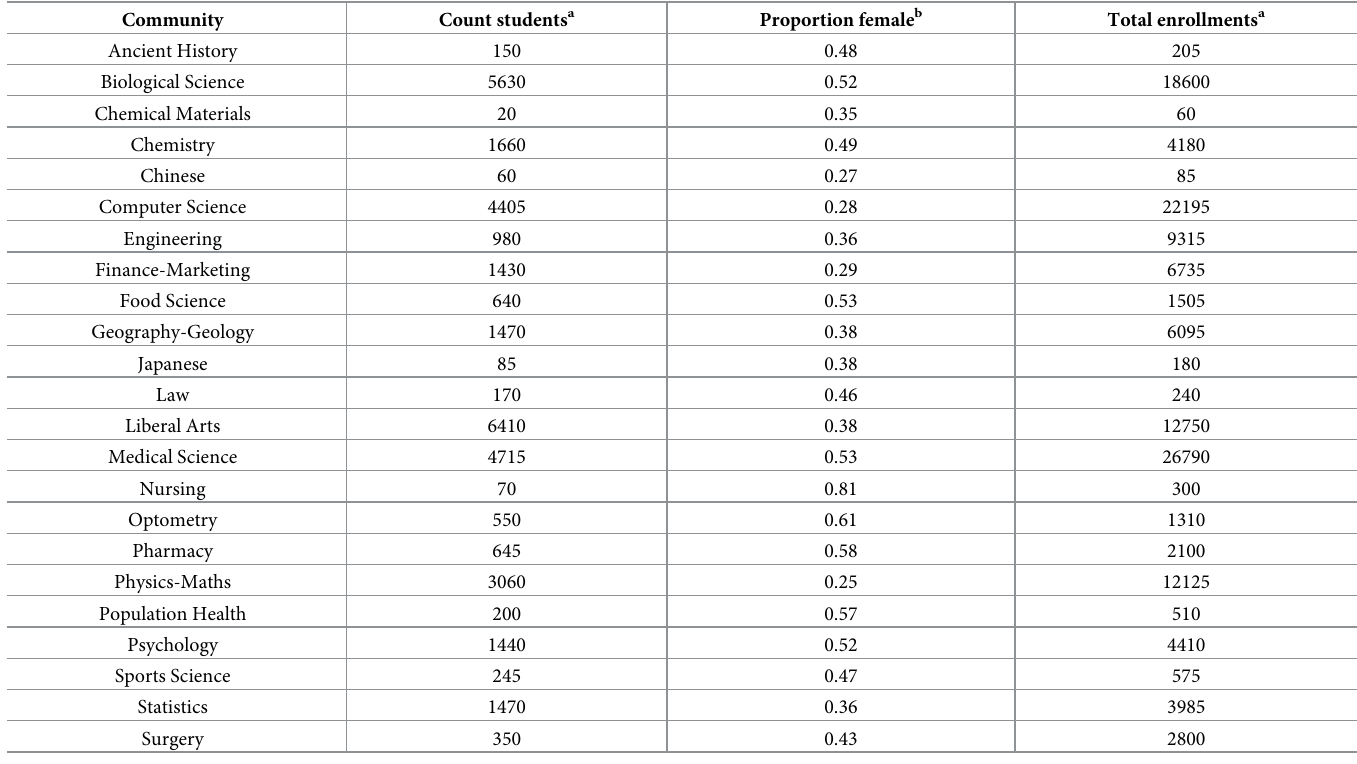
Table 1. Compositions of the communities detected in the co-enrollment